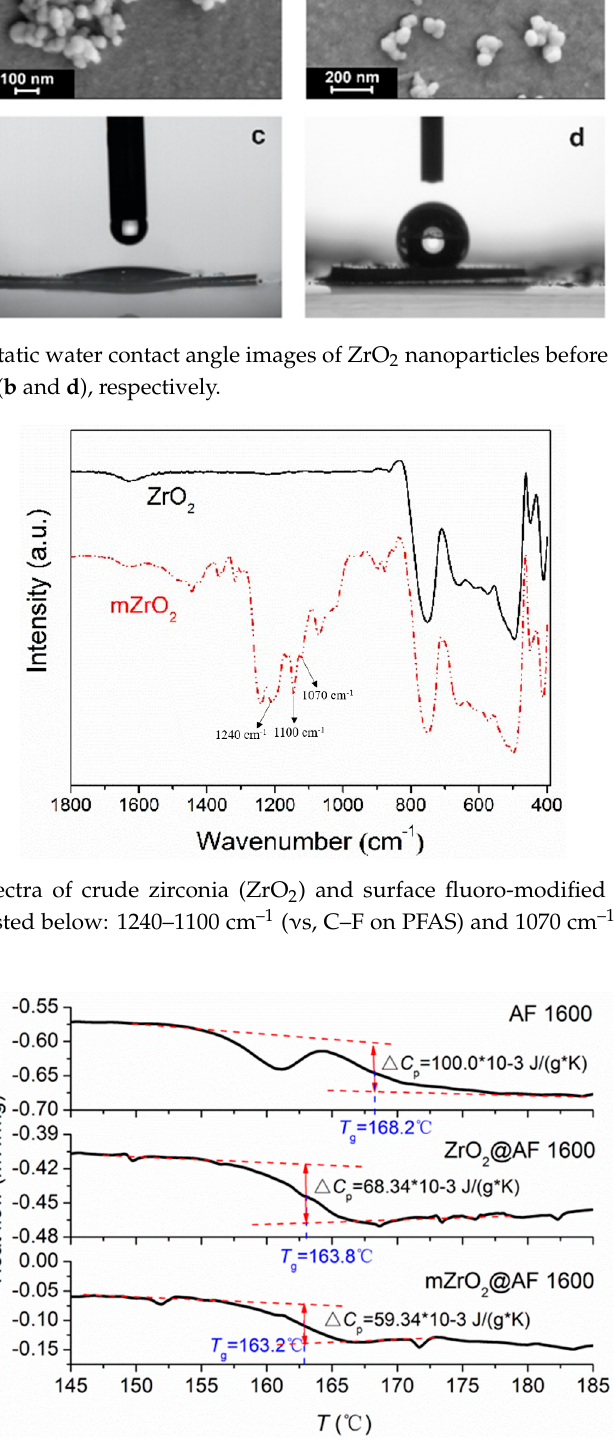
Figure 3. DSC heating curves of AF 1600, ZrO 2 @AF 1600 and mZrO 2 @AF 1600 samples ( Δ C p : the specific heat capacity). specific heat